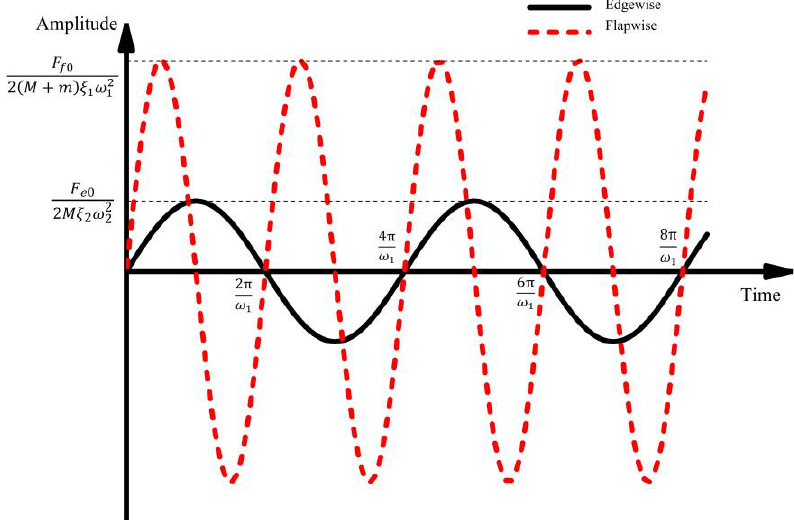
Figure 22. Schematic diagram of blade vibration track in biaxial fatigue test.